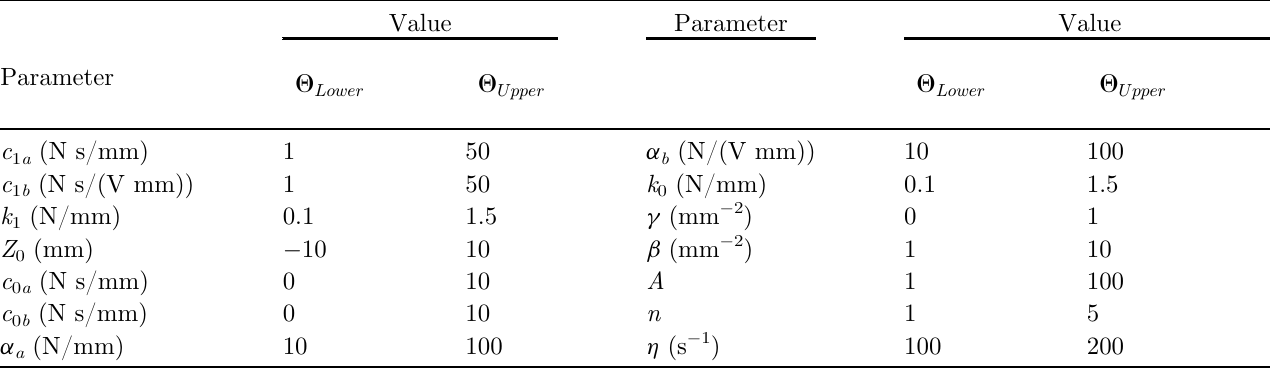
Table 2. The constraint values of the parameter vector Q .